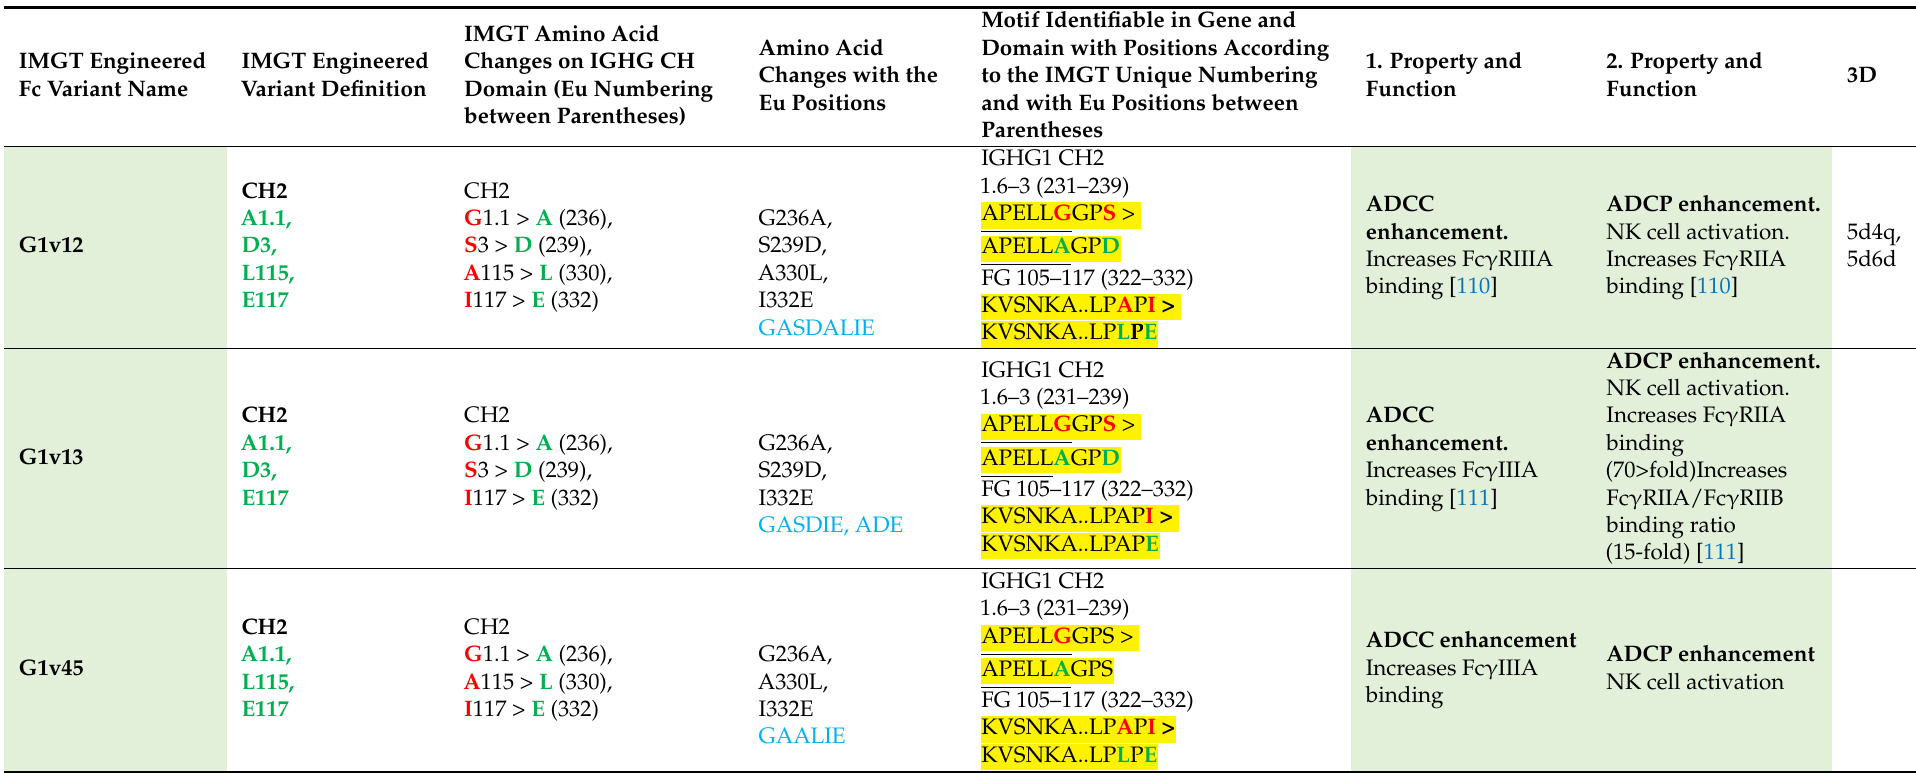
Table 7. IMGT nomenclature, Eu positions and IMGT motif of engineered Fc variants involved in antibody-dependent cellular cytotoxicity (ADCC) and antibody- dependent cellular phagocytosis (ADCP) enhancement (Effector